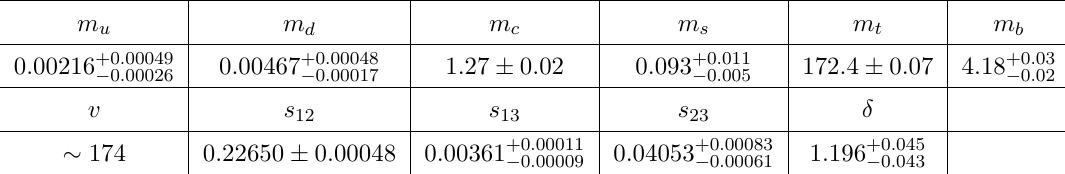
Table 1. Experimentally measured masses in GeV and mixing angles of quarks from ref.